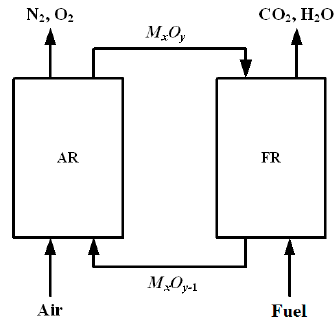
Figure 1. A schematic diagram of the chemical looping combustion (CLC) system.